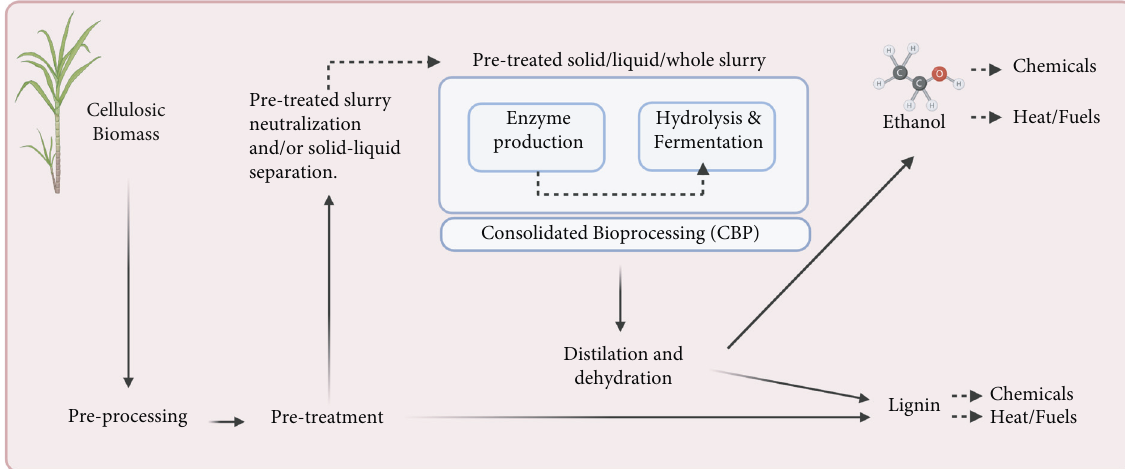
Figure 4: Flowchart showing the production of second-generation ethanol. ∗ Image was created using